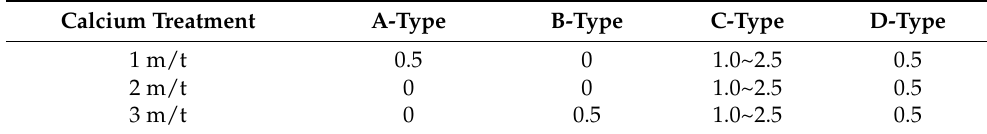
Table 9. Rating of the inclusion in hot rolled plate. (GB/T 10561-2005).